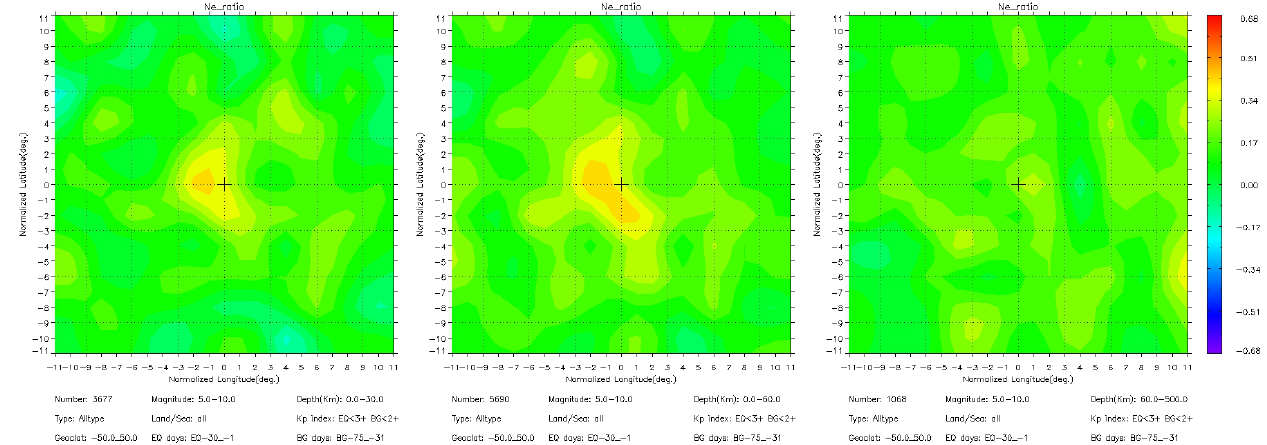
Fig. 6. The plots are similar to the right panel of Fig. 2, but it concerns statistical results with seismic events at different depth levels (the depth was 0 ∼ 30km in the left panel, 0 ∼ 60km in the middle panel and 60 ∼ 500km in the right panel). The middle panel is similar to the one in Fig. 2 and is just here to facilitate the comparison.